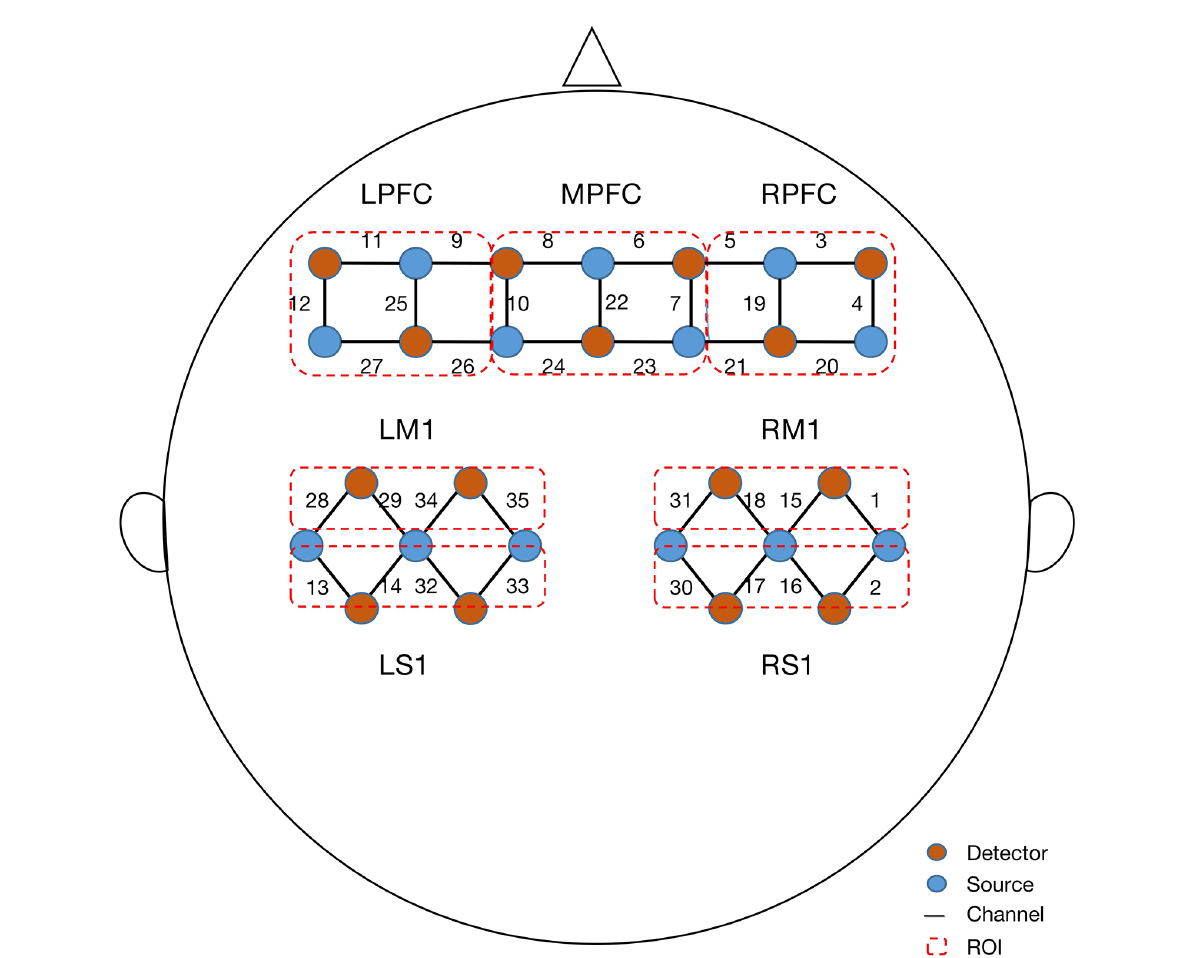
FIGURE2 Configuration of fNIRS channels. The red dots represent detectors and the blue dots represent light sources. In total, 13 sources and 15 detectors resulted in 35 channels encompassing seven regions of interest, specifically, left prefrontal cortex (LPFC), middle prefrontal cortex (MPFC), right prefrontal cortex (RPFC), left primary motor cortex (LM1), right primary motor cortex (RM1), left primary sensory cortex (LS1), and right primary sensory cortex (RS1).